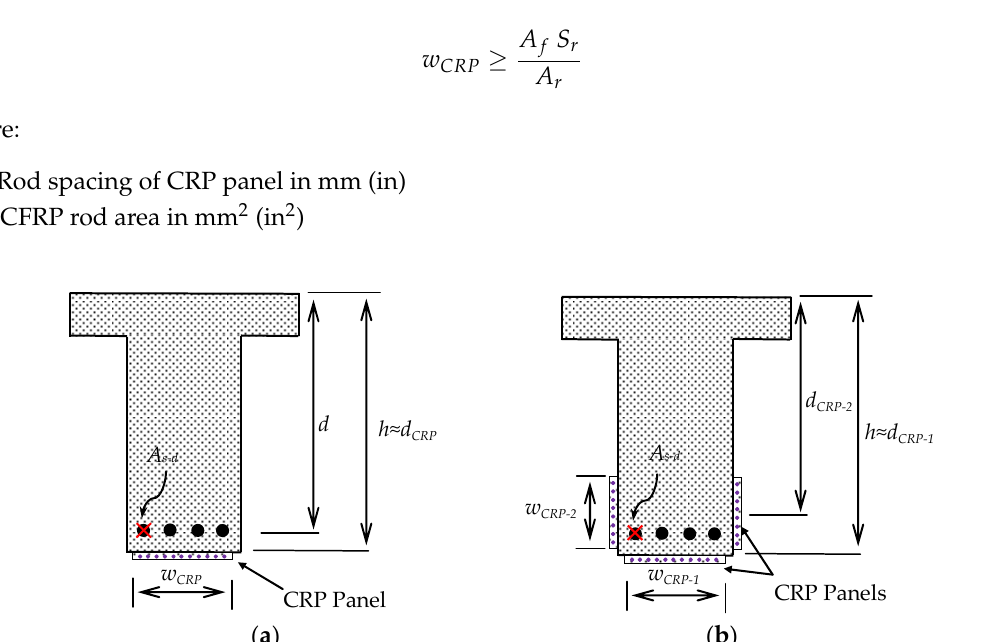
Figure 5. CRP application ( a ) On bottom surface; ( b ) On bottom surface and sides.